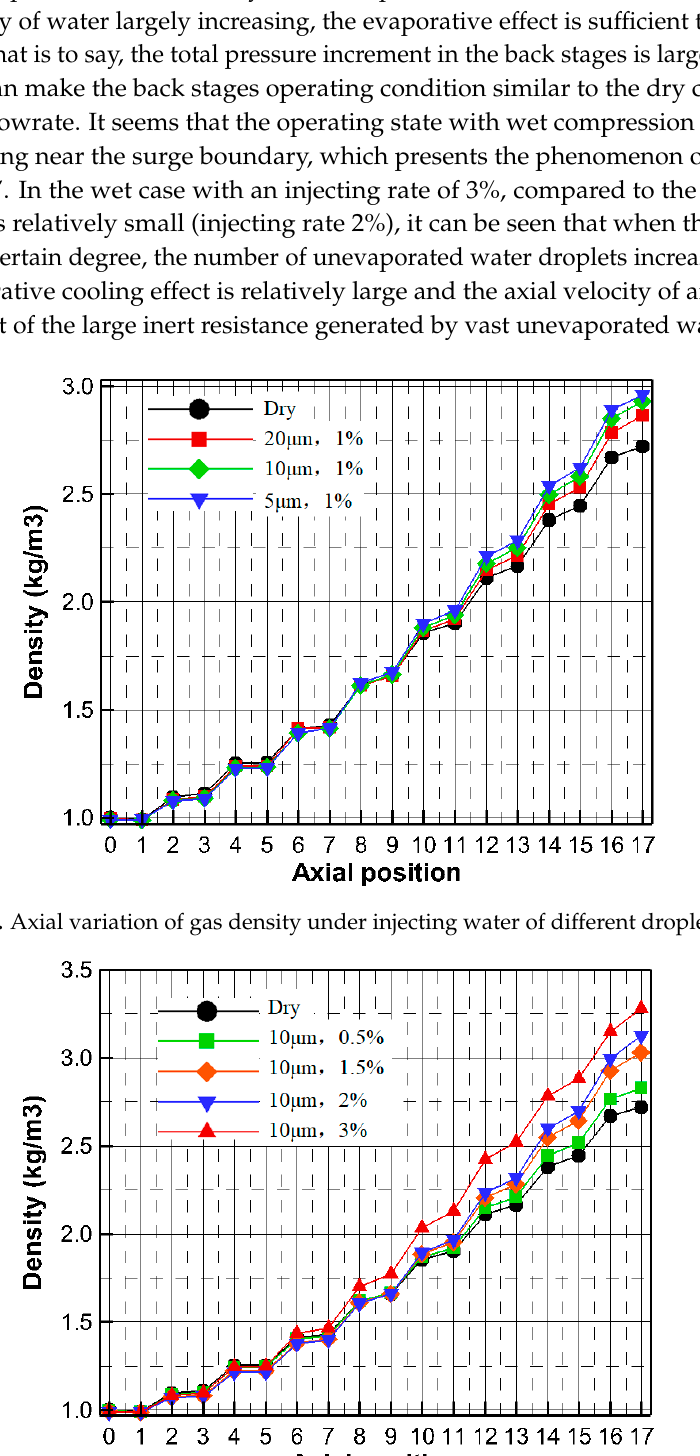
Figure 33. Axial variation of axial velocity under injecting water of different droplet sizes.